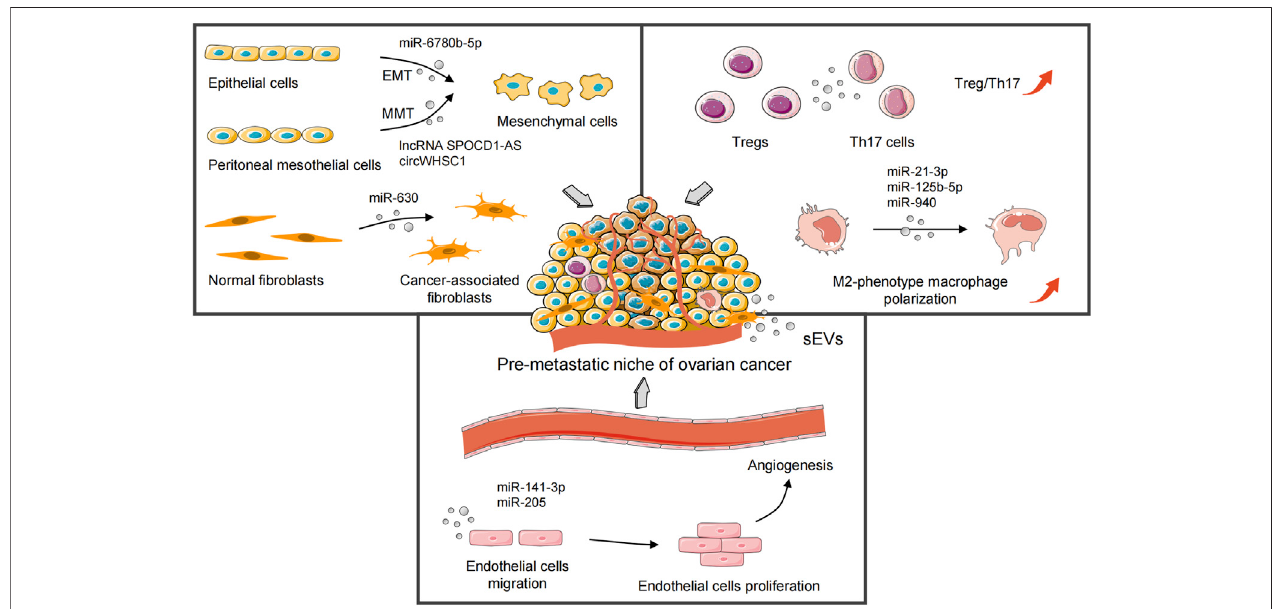
FIGURE 2 | sEVs-derived oncogenic ncRNAs mediate formation of the pre-metastatic niche of ovarian cancer by local stromal remodeling, immunosuppression andevasion,andangiogenesis.sEVs,smallextracellularvesicles;EMT,epithelial – mesenchymaltransition;MMT,mesothelial – mesenchymaltransition;Tregs,regulatory T cells; Th17 cells, T helper 17 cells.